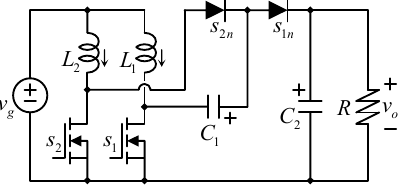
Figure 3. The series-capacitor boost converter (the converter understudy).